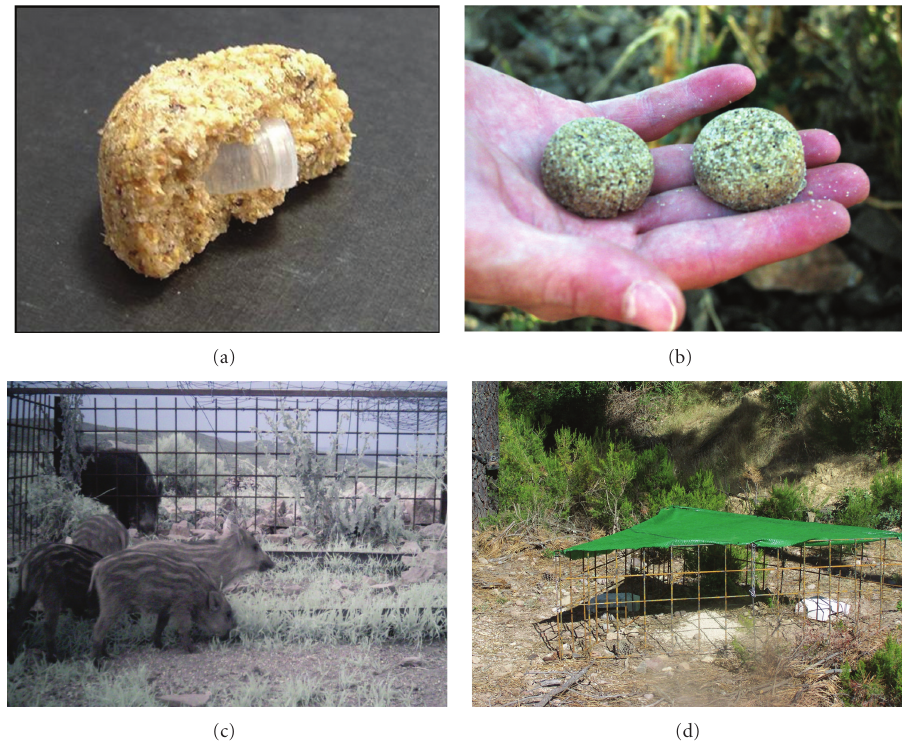
Figure 1: (a) and (b) Baits developed to deliver vaccines to wild boar in Spain. They are composed of piglet feed, para ffi n, sucrose and cinnamon-tru ffl e powder attractant. (c) Wild boar piglets consuming baits inside selective feeders. (d) Portable selective feeder used to deliver baits to young wild